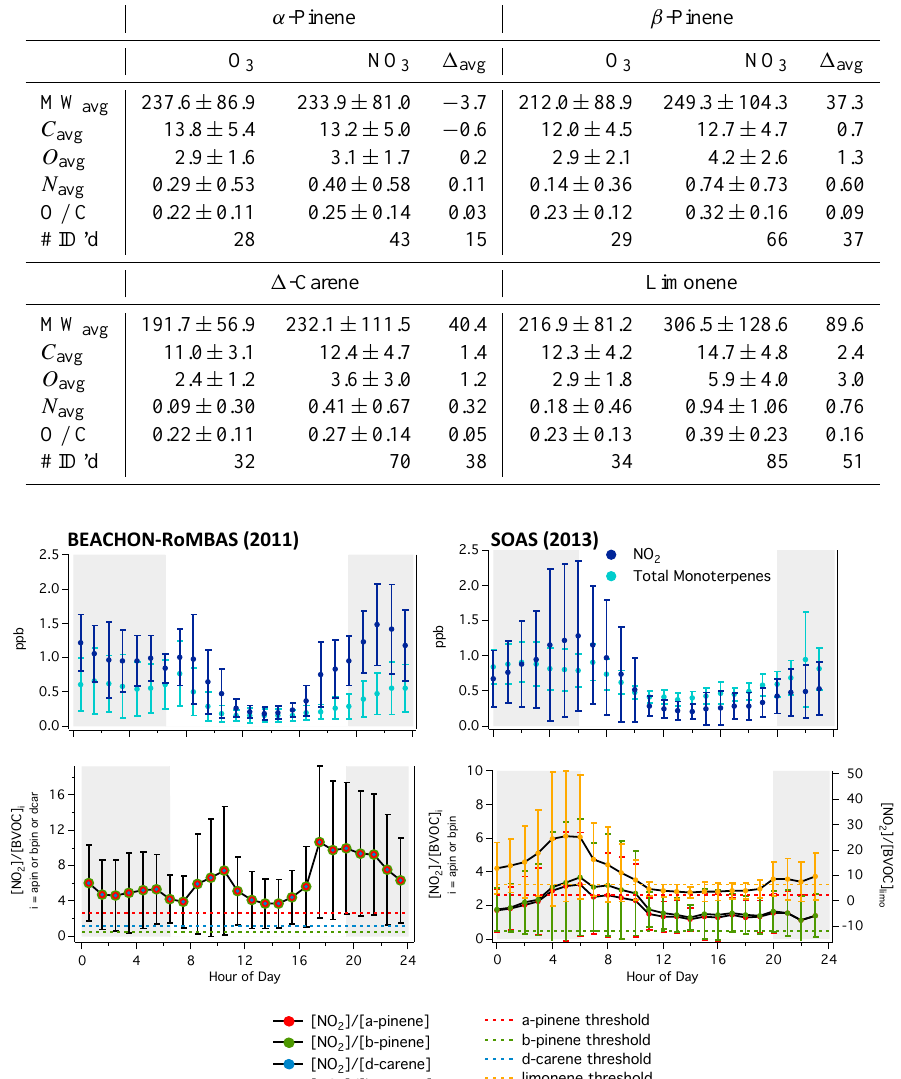
Table 4. Average ( ± 1 standard deviation) molecular weight, number of C, O, and N atoms, O / C, and total number of products identified by HPLC-ESI-MS analysis of aerosol collected from O 3 and NO 3 (O 3 + NO 2 + NO 3 ) oxidation of each monoterpene studied. The difference in average value for each parameter ( (cid:49) avg ) from each oxidation scheme was also tabulated for each monoterpene. α -Pinene